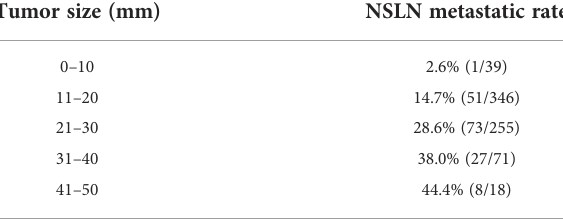
TABLE 4 Relationship between tumor size and NSLN metastasis in the whole